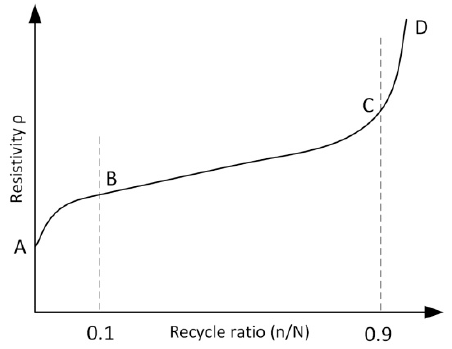
Figure 12. Fatigue resistivity cycle ratio curve diagram.